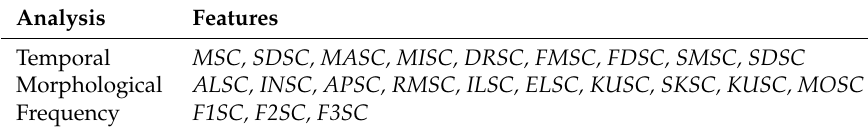
Table 1. Temporal, morphological and frequency features computed for EDA